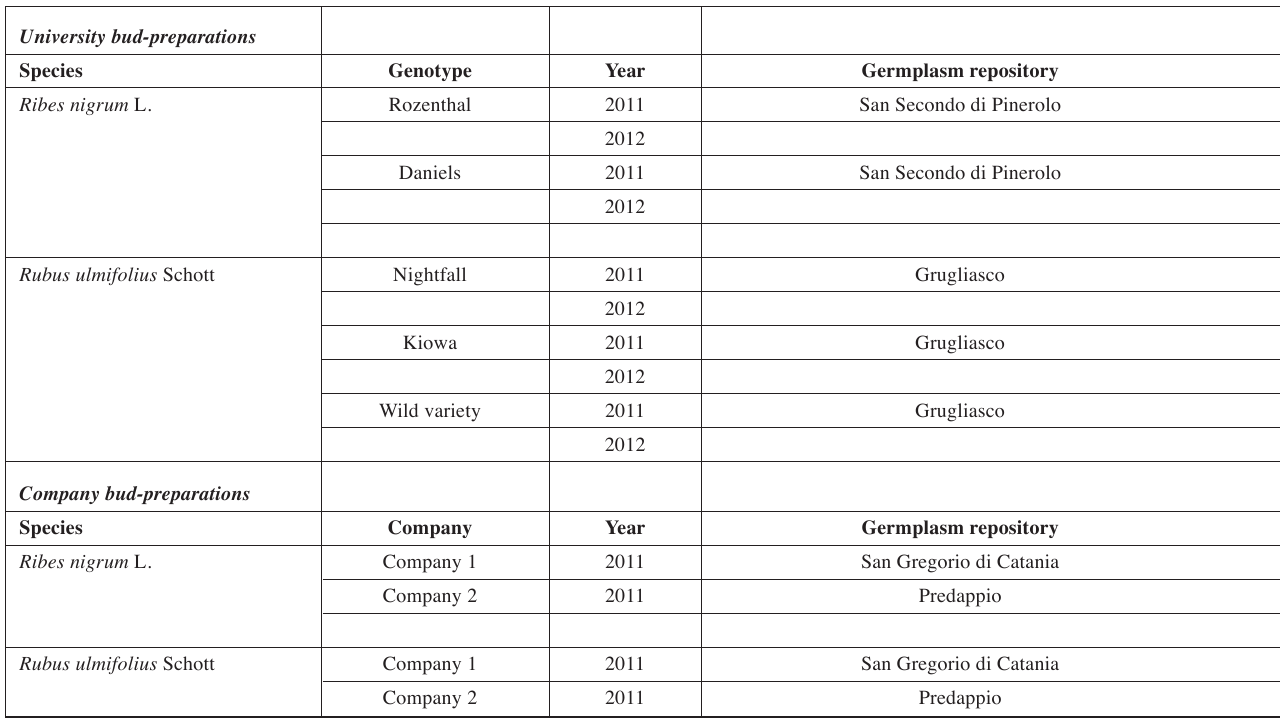
Tab. 1: Species, genotype, sampling time and picking site of the analysed